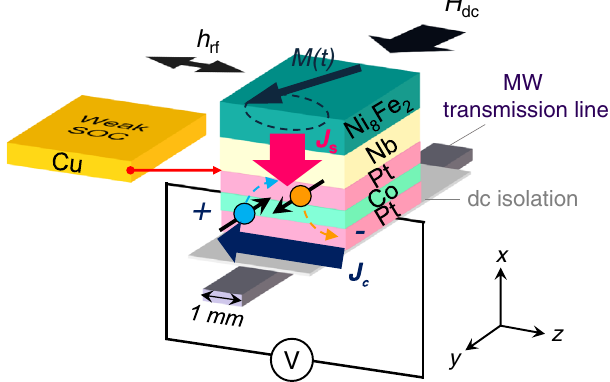
FIG. 6. Measurement scheme of the spin-pumping-induced inverse spin Hall effect (ISHE). A dynamically injected spin current J from precessing Ni 8 Fe 2 through Nb into Pt = Co = Pt spin s sink is converted into a transverse charge current J (mostly in the Pt = Co = Pt spin sink), producing a measurable electromotive force V